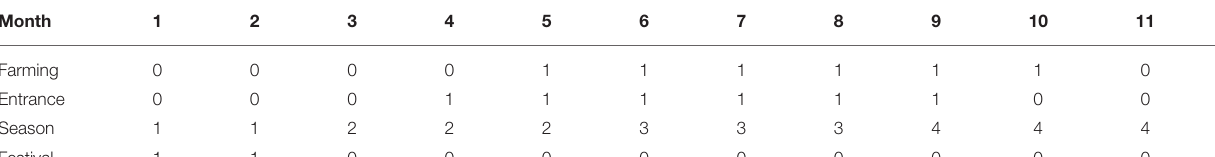
TABLE 1 | Data of social factors.